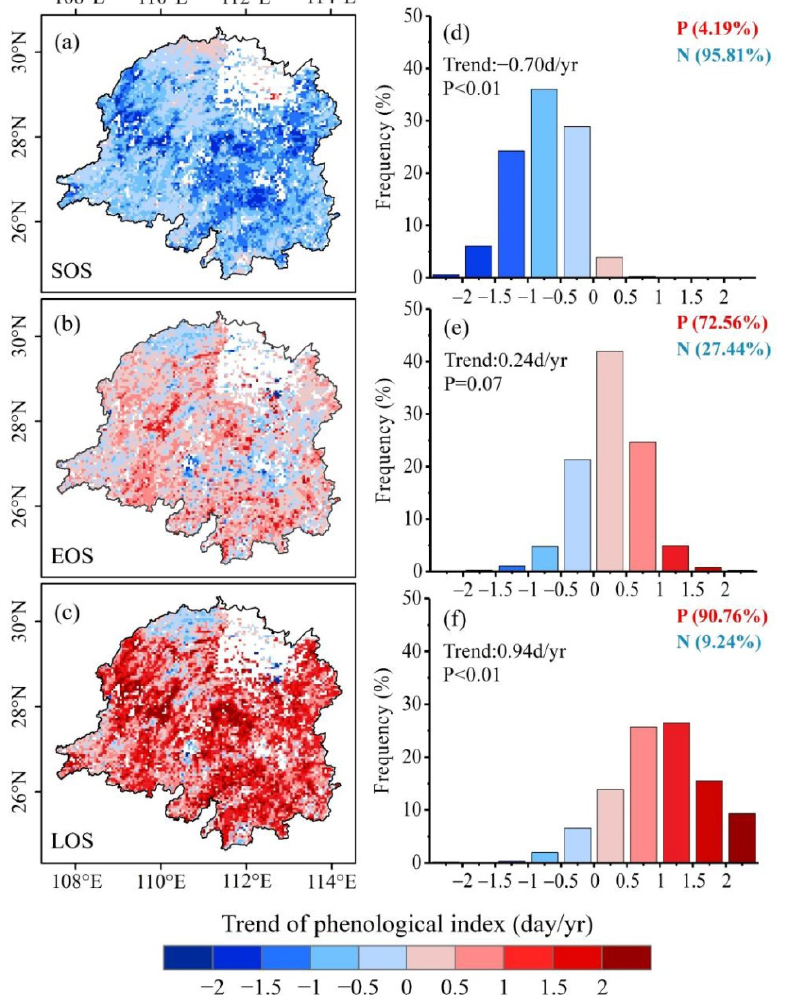
Figure 3. Vegetation phenology trends and frequency distribution in the Dongting Lake basin dur- ing 2000–2017. ( a,d ) for the start of the growing season (SOS), ( b,e ) for the end of the growing season (EOS) and ( c,f ) for the length of growing season (LOS).